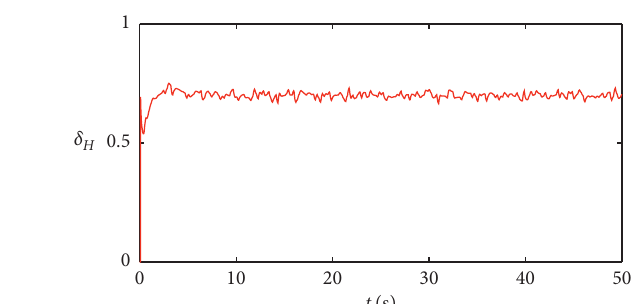
Figure 15: Height control of RSLQR. Figure 16: Control input of the vertical